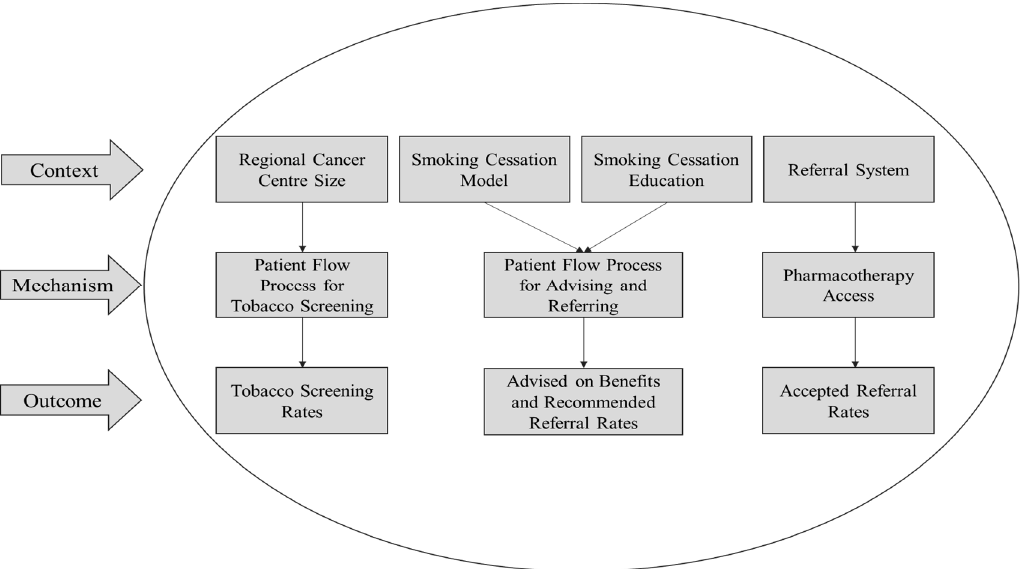
Figure 1. Context–Mechanism–Outcome (CMO) variable interactions. Individual interactions between specific context, mechanism and outcome variables identified based on pattern similarities between top-performing Regional Cancer Centres.